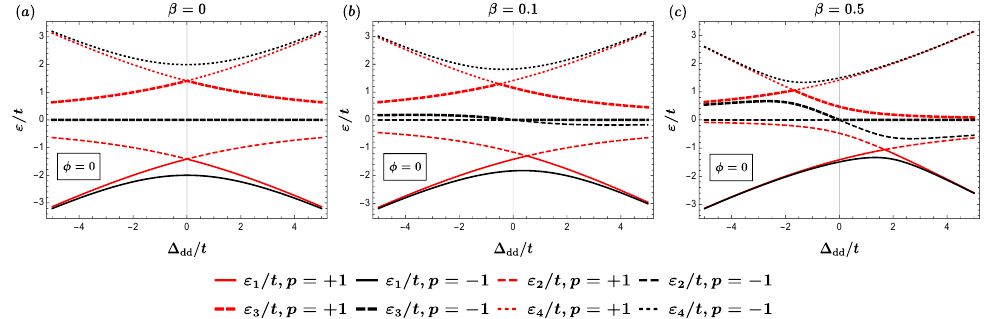
Figure 7: Eigenenergies of the Hamiltonian (13) for different parities p and as a function of QD-QD detuning ∆ for various values of coupling asymmetry β . dd